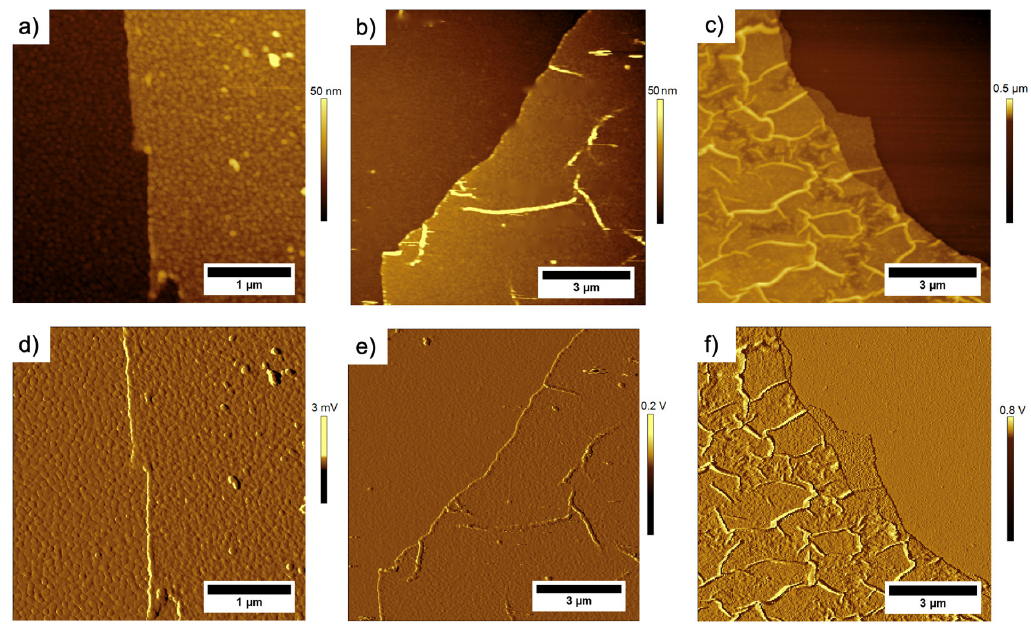
Figure 3. AFM contact mode images of PDA film deposited with different number of pulse cycles. Topography ( a – c ) and deflection images ( d – f )) are shown: ( a , d ) PDA film deposited with 1 pulse cycle; ( b , e ) PDA film deposited with 3 pulse cycles and ( c , f ) PDA film deposited with 30 pulse cycles. Images were recorded in contact mode. The displayed images are tilt